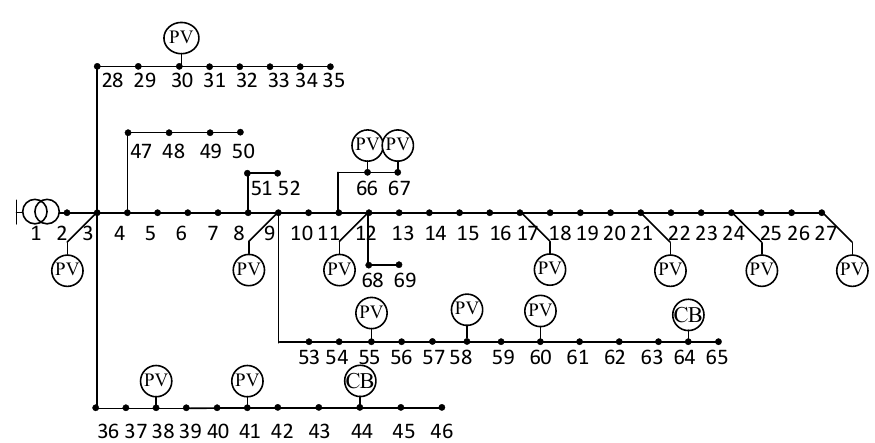
Fig. 4. PG&E69 distribution system structure